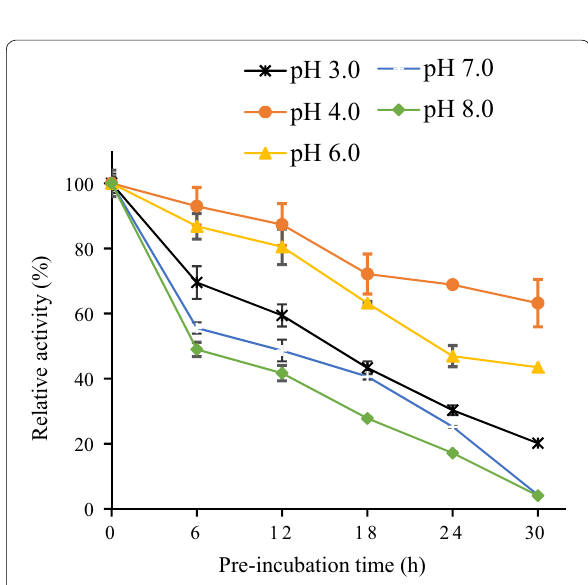
Fig. 6 Effect of pH on stability of the AMG. The enzyme was pre-incubated (37 °C) for 6, 12, 18, 24, and 30 h before the assay was carried out at 45 °C for 1 h. All error bars are represented as the standard errors of the means